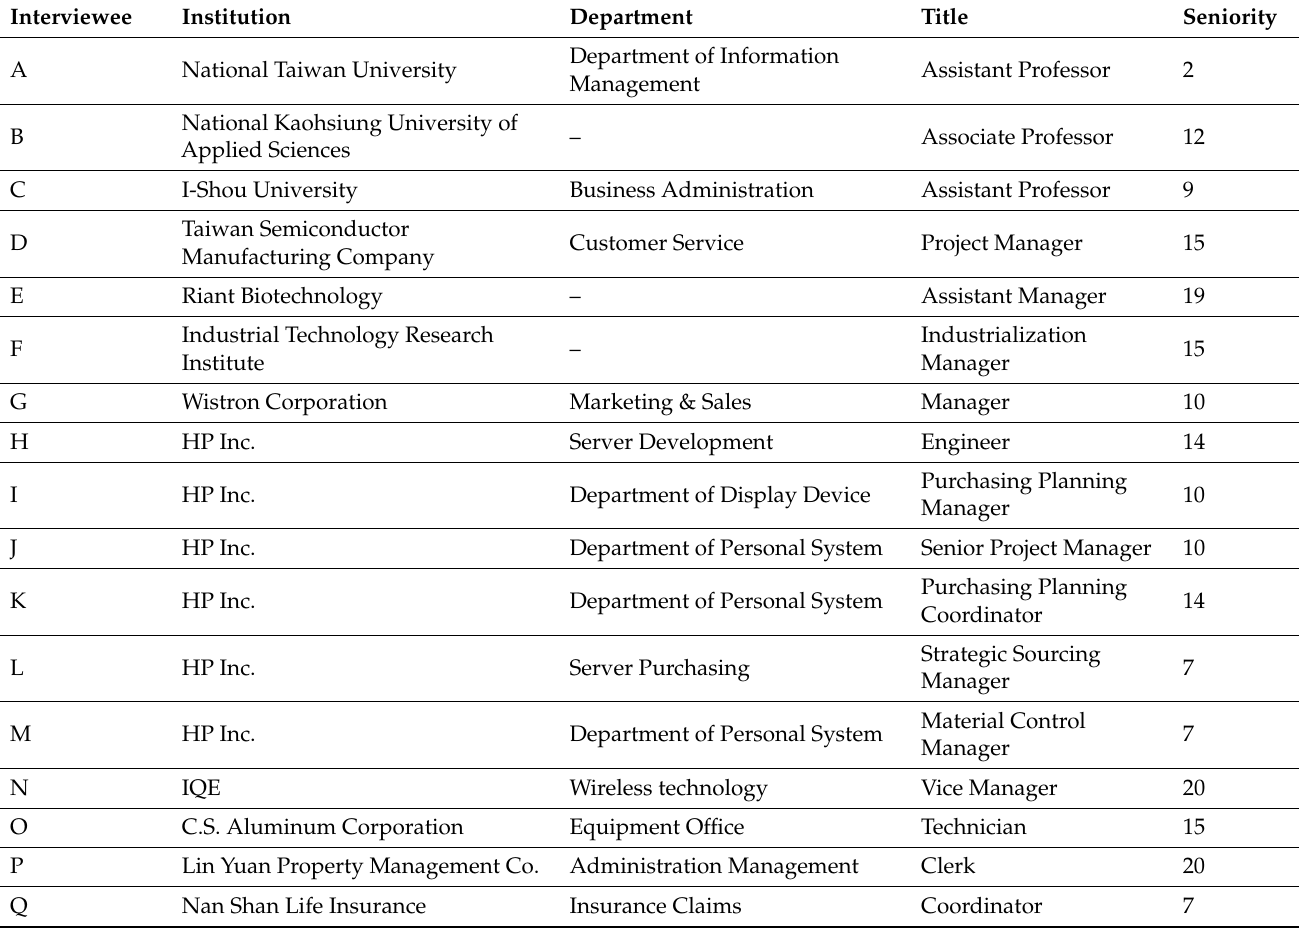
Table 1. Basic information on interviewees.